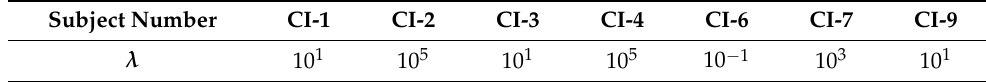
Table 1. Selected λ for CI